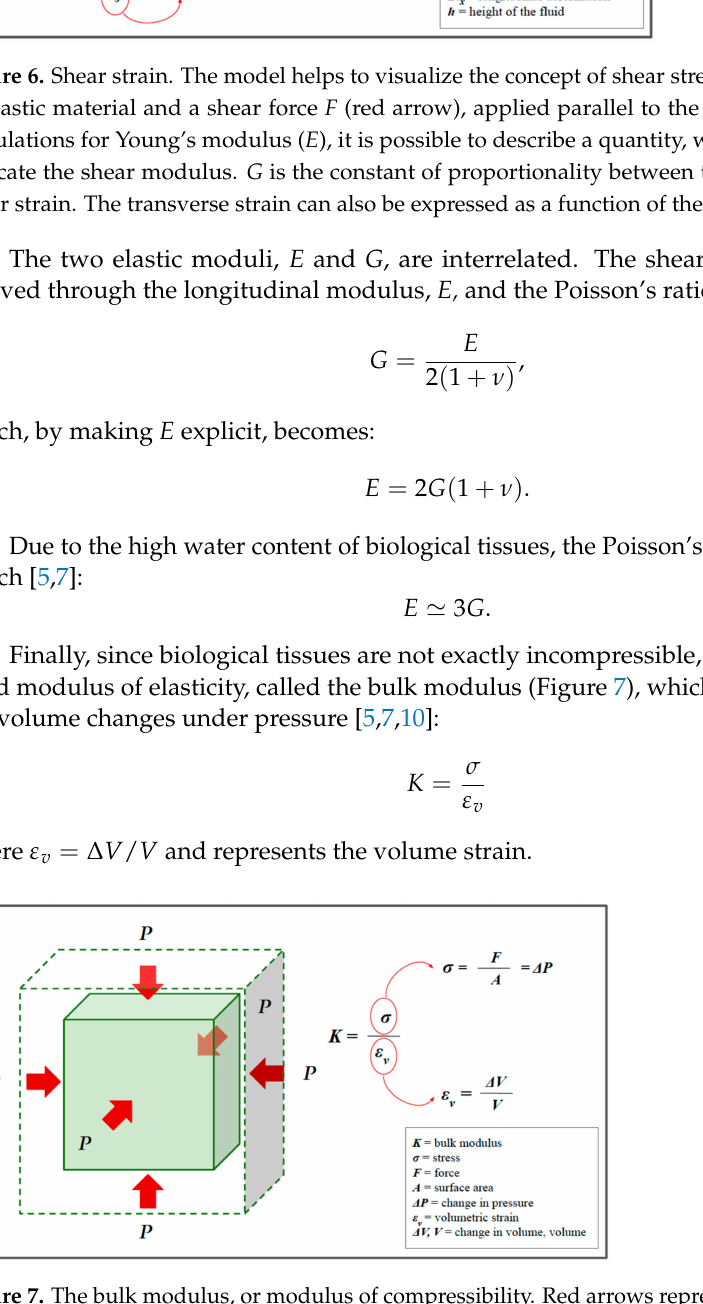
Figure 7. The bulk modulus, or modulus of compressibility. Red arrows represent the pressure acting on the surface. In the bulk modulus equation the volumetric stress is usually expressed as a pressure P (force to surface area ratio) or, more precisely, the change in